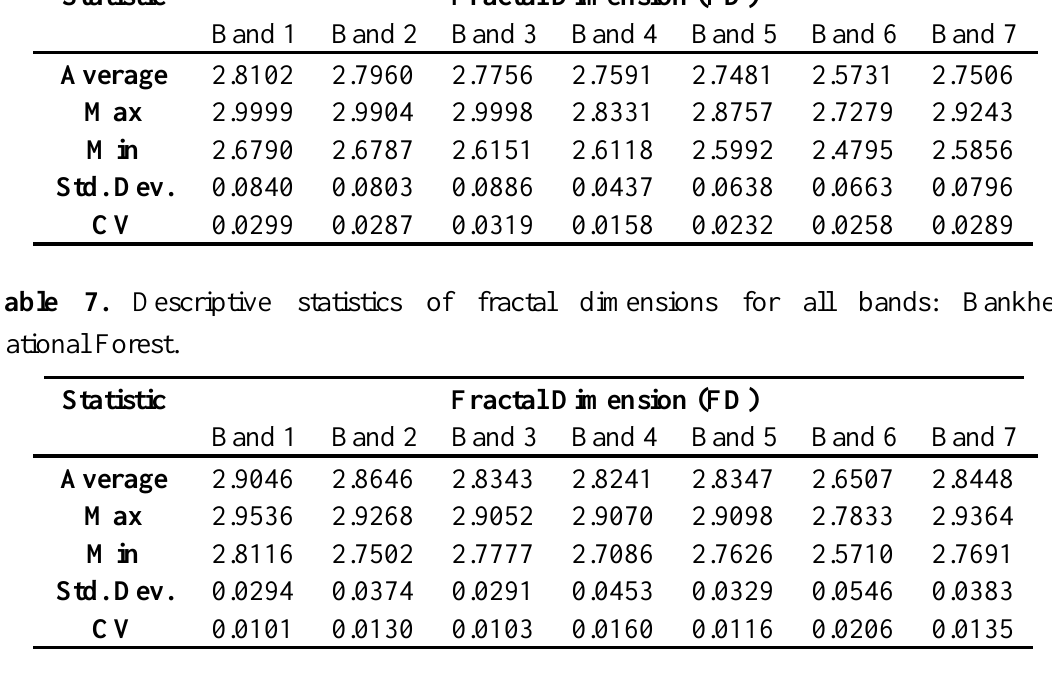
Table 8. Descriptive statistics of fractal dimensions for all bands: Chattahoochee National